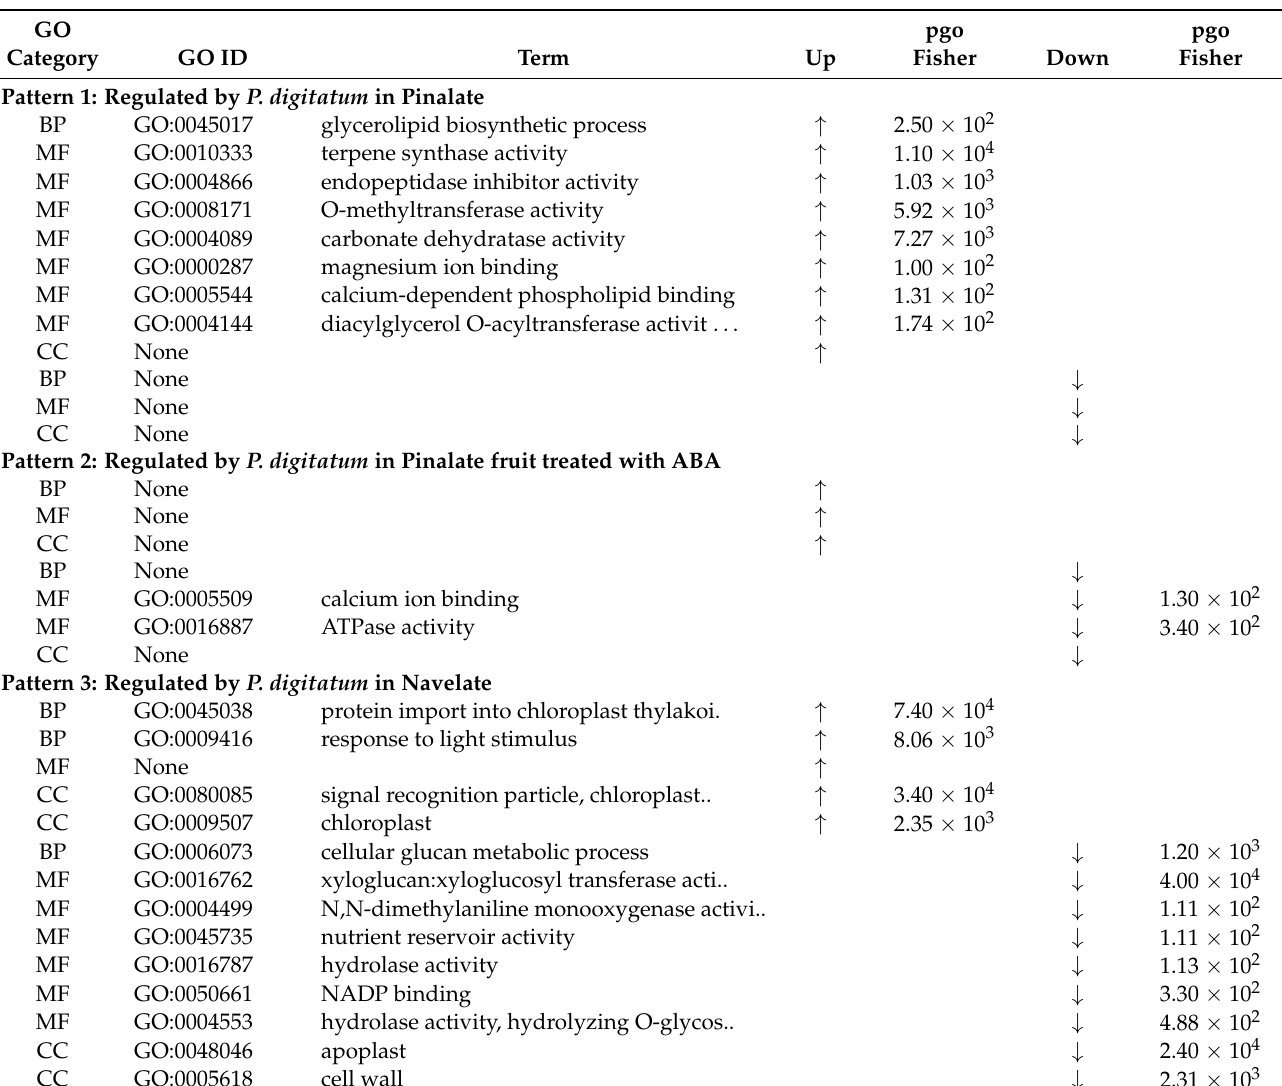
Table 4. Comparison of the biological (BP) and molecular function (MF) processes, and of the cell components (CC) induced ( ↑ ) or repressed ( ↓ ), in the Pinalate fruit treated or not with ABA, and in the Navelate fruit inoculated with P. digitatum (10 4 conidia mL − 1 ) by 1 d post-inoculation (1 dpi) vs. their wounded (control) fruit. Only the DEGs ( p ≤ 0.05) that met a cutoff of |Log 2 FoldChange| ≥ 1 were considered in the analysis. Three biological replicates from each condition were used.